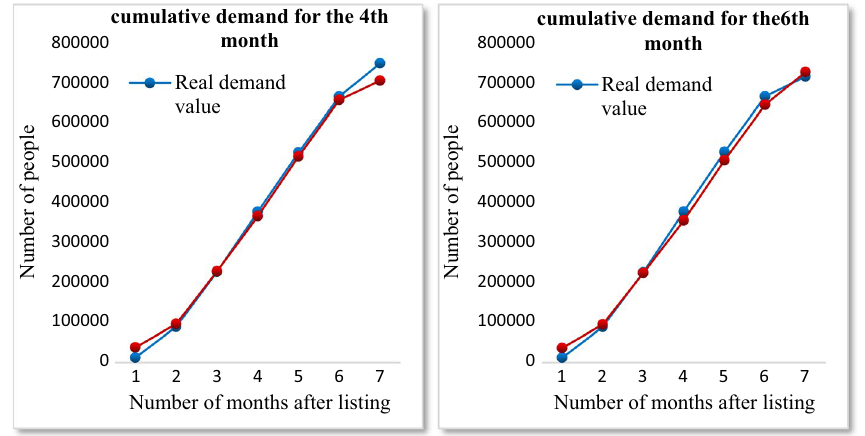
Fig. 11 Comparison of cumulative demand forecast and true value in the 4th and 6th months